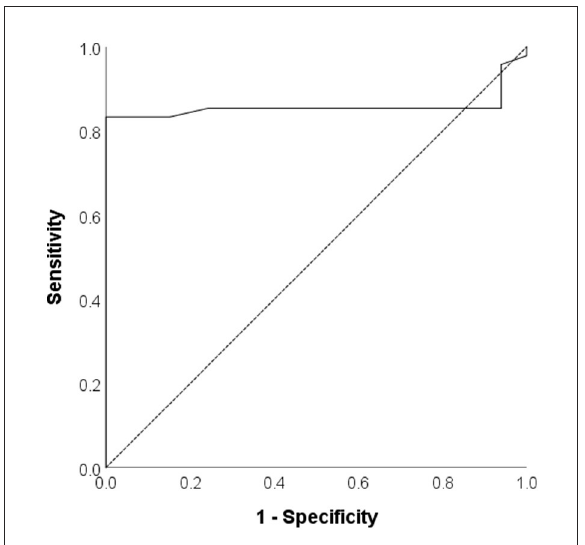
FIGURE2 The Receiver operating curve for transverse rectal diameter in distinguishing children with upper urinary tract